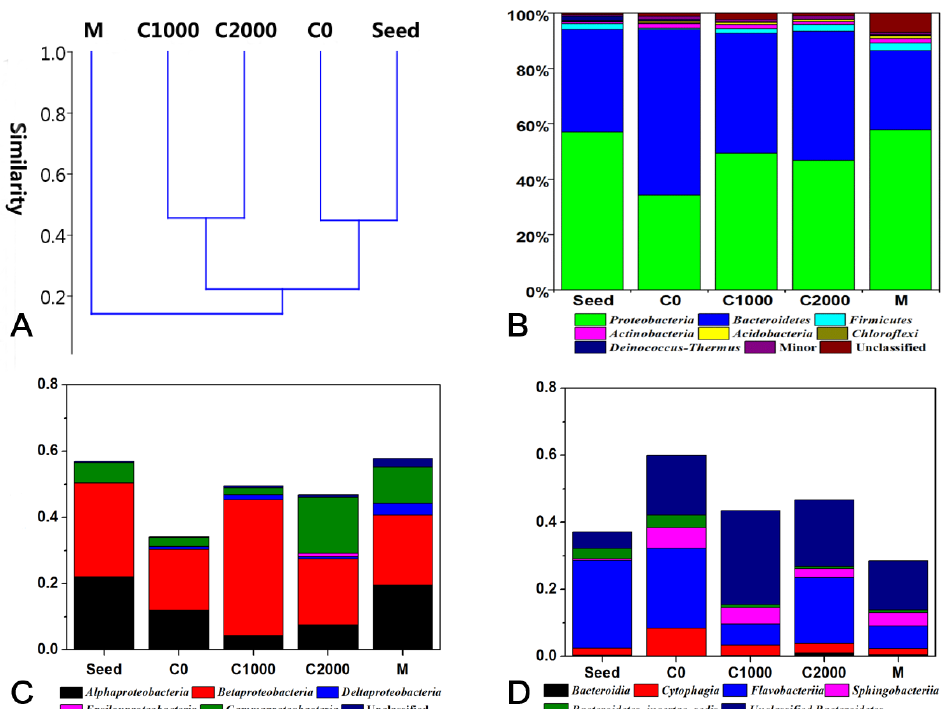
Figure 4. ( A ) Microbial richness and ( B ) diversity index of all sludge samples.